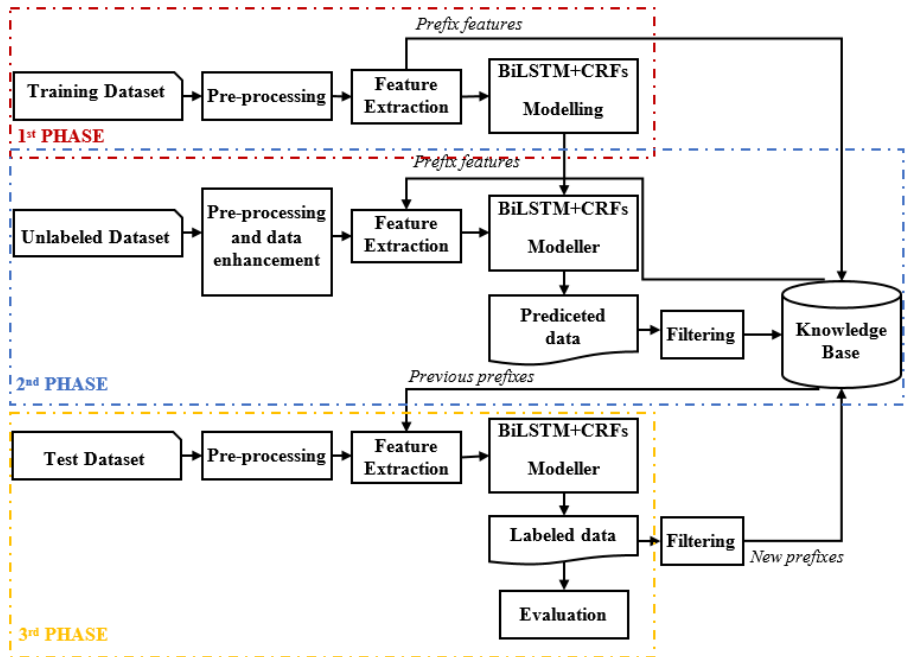
Fig. 2. DeepLML – NER: The character-level deep lifelong learning model for